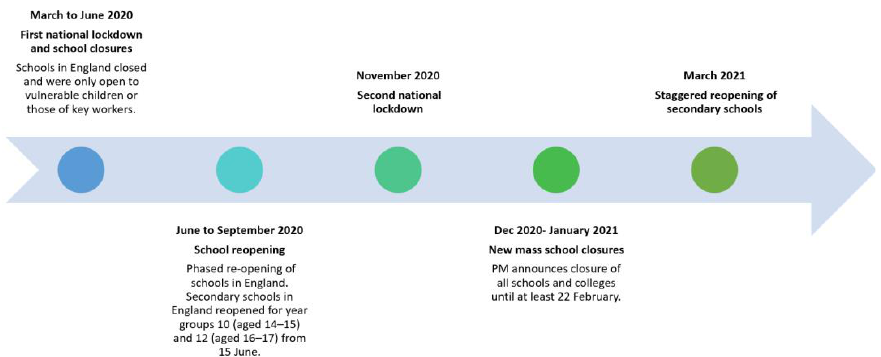
Figure 1. Timeline of school closures and national lockdowns.